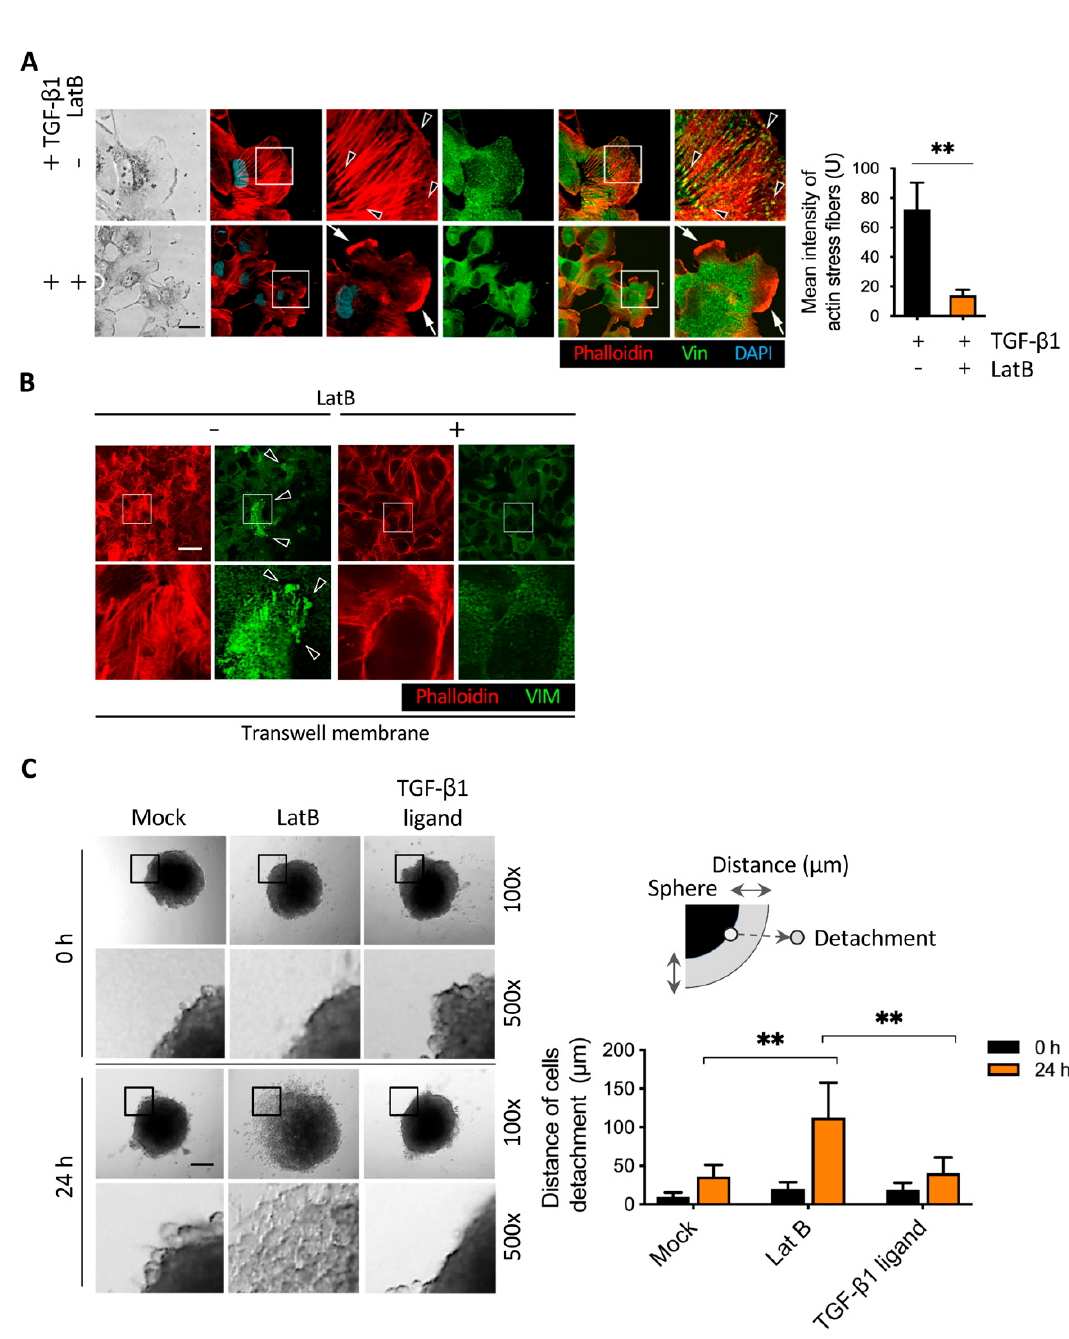
Figure 8. Latrunculin B induced focal adhesion complex translocation and cells spatial detachment. ( A ) Images of representative immunofluorescence results showed that adding latrunculin B induced vinculin translocation. BFTC909 cells were seeded in a wound healing chamber overnight, followed by migration with or without treatment of TGF- β 1 ligands or latrunculin B for 24 h. Black arrow: actin stress fibers. White arrow: lamellipodia. ( B ) Treatment of latrunculin B induced vinculin translocation in the Boyden chamber assay. The cells were fixed and stained with anti-vinculin antibody and phalloidin. Arrowheads: vinculin accumulation. Scale bars: 10 μ m. ** p < 0.01. Data are means ± s.d. (two-tailed t-test) from experiments with three replicates ( n = 3). ( C ) Treatment of latrunculin B increased cell detachment in a 3D in-gel spheroid assay. The spheres were embedded in the materiel with 10% FBS for 24 h. Scale bars: 100 μ m. ** p < 0.01. Data are means ± s.d. (two-way ANOVA with Tukey’s multiple comparisons test) from experiments with three replicates ( n = 3). LatB, latrunculin B.